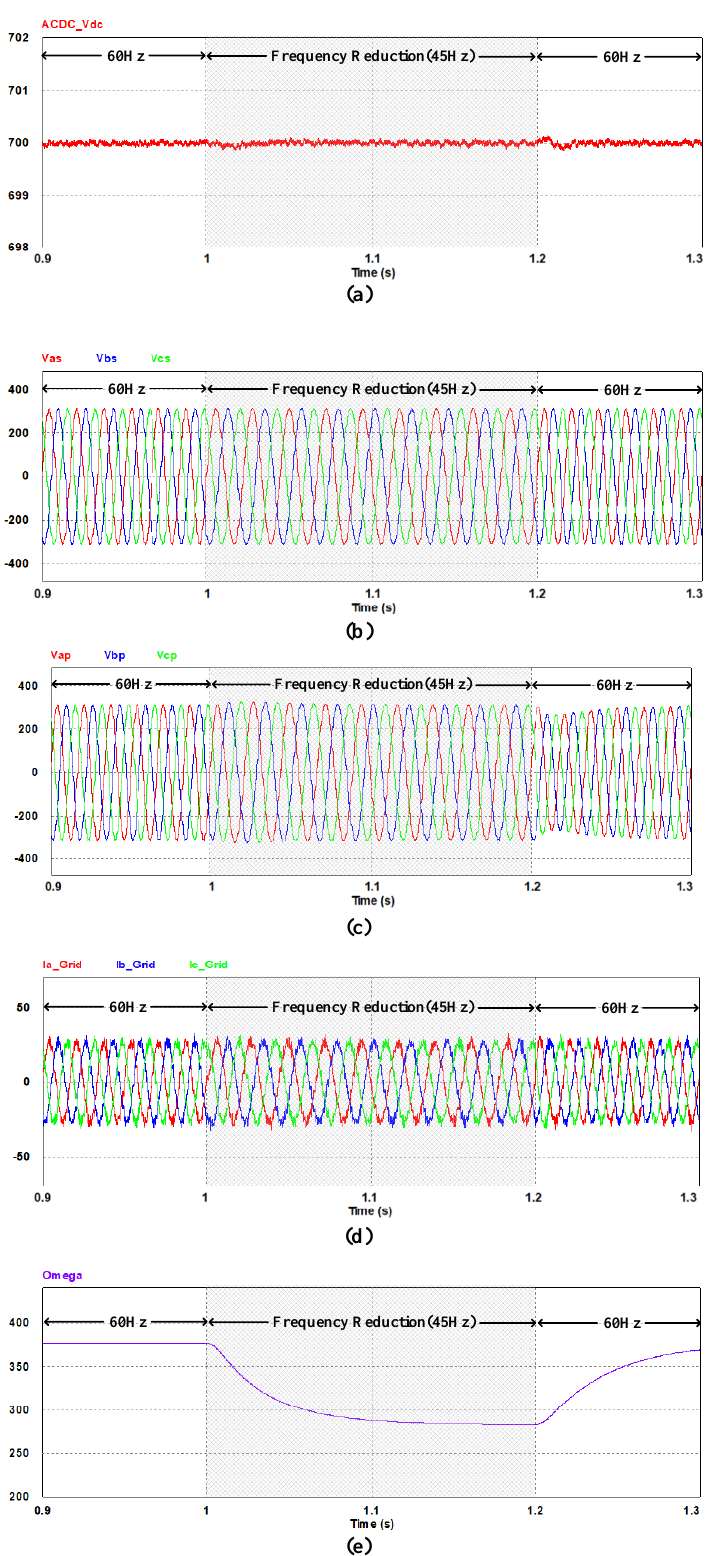
Figure 20. Waveforms of simulation results when grid frequency decreased from 60 Hz to 45 Hz drop; ( a ) the dc-link voltage; ( b ) the 3-phase input voltage; ( c ) the 3-phase input positive voltage detected by SOGI-FLL; ( d ) the 3-phase input current; and, ( e ) the center frequency that was extracted from SOGI-FLL.